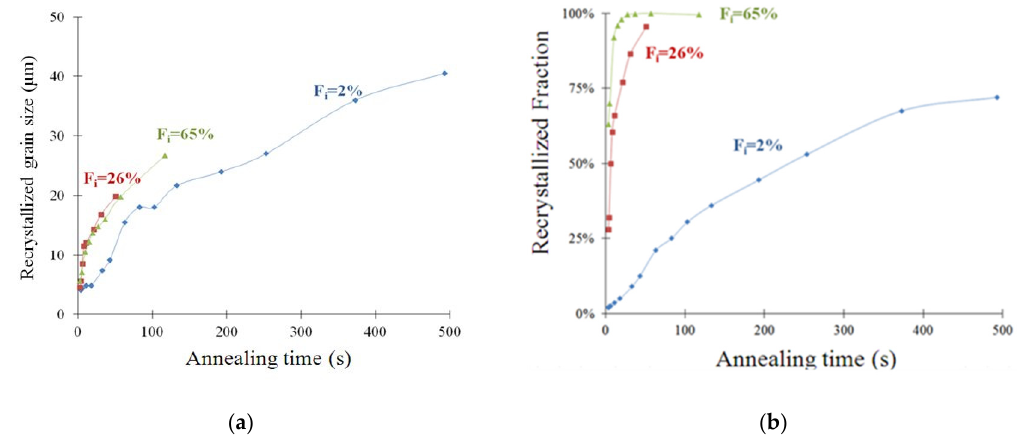
Figure 8. Post-dynamic recrystallization kinetics in samples A, B and C, with an initial DRX volume fraction (noted F i on the curves) of 2%, 26% and 65%, respectively. ( a ) Average recrystallized grain size; ( b ) Recrystallized volume fraction.